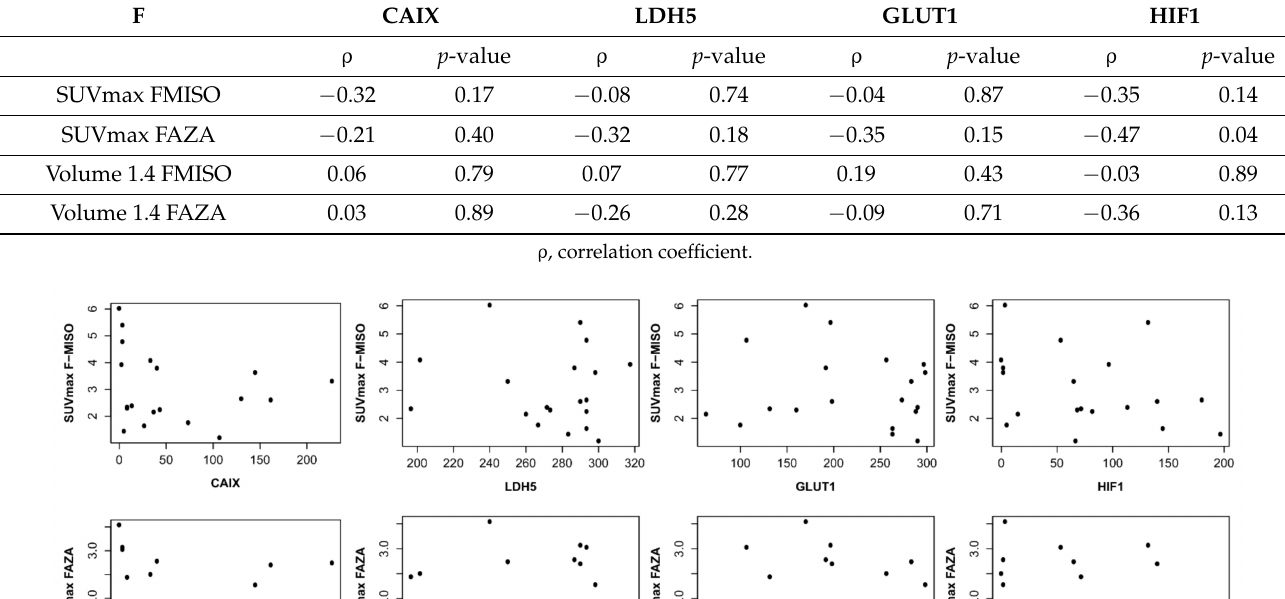
Table 3. Correlation between immunohistochemical and hypoxia PET.